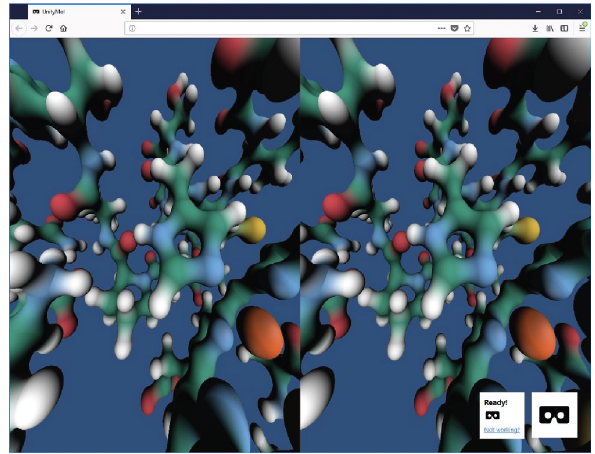
Figure 6: Screen capture of UnityMol WebGL+WebVR. The Firefox web browser (version 55 and up) hosts the WebVR version of UnityMol as integrated to MinOmics. Different devices can be addressed, here full-fledged HMDs, but